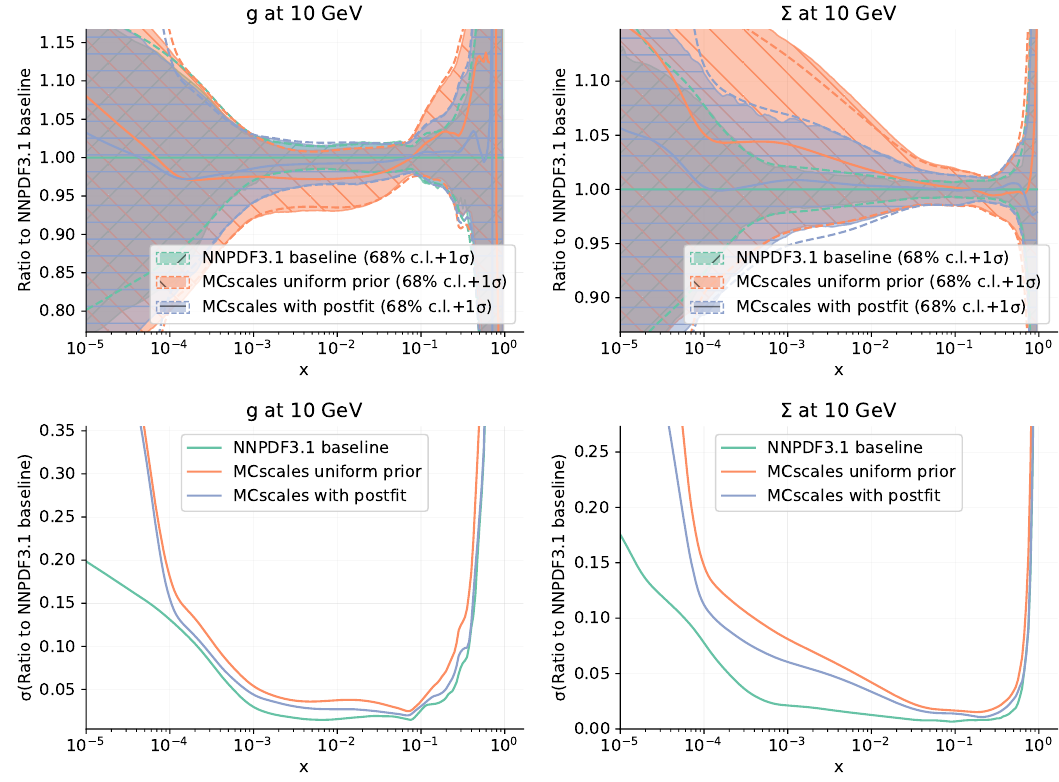
Figure 5 . Top: plots of the gluon (left) and singlet Σ (right) PDFs at Q = 10 GeV, where NNPDF3.1 baseline (green) is compared to MCscales uniform prior (orange) and the same fit with after postfit (blue). Bottom: The 1 σ PDF uncertainties, normalised to the central value of the NNPDF3.1 baseline